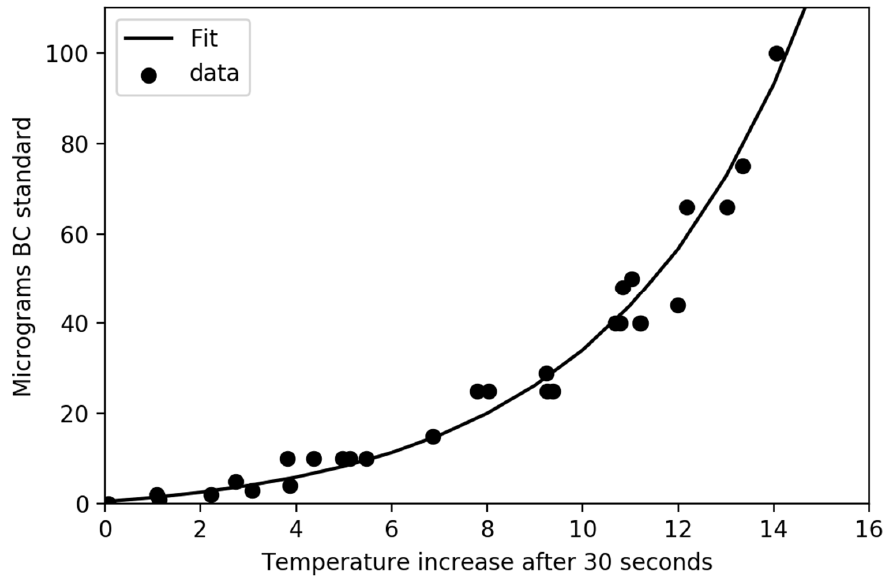
Figure 3. Calibration curve developed for LAHM for fullerene soot coated Millipore filters. Each dot represents one calibration filter, and the solid line is an empirical fit to the data.